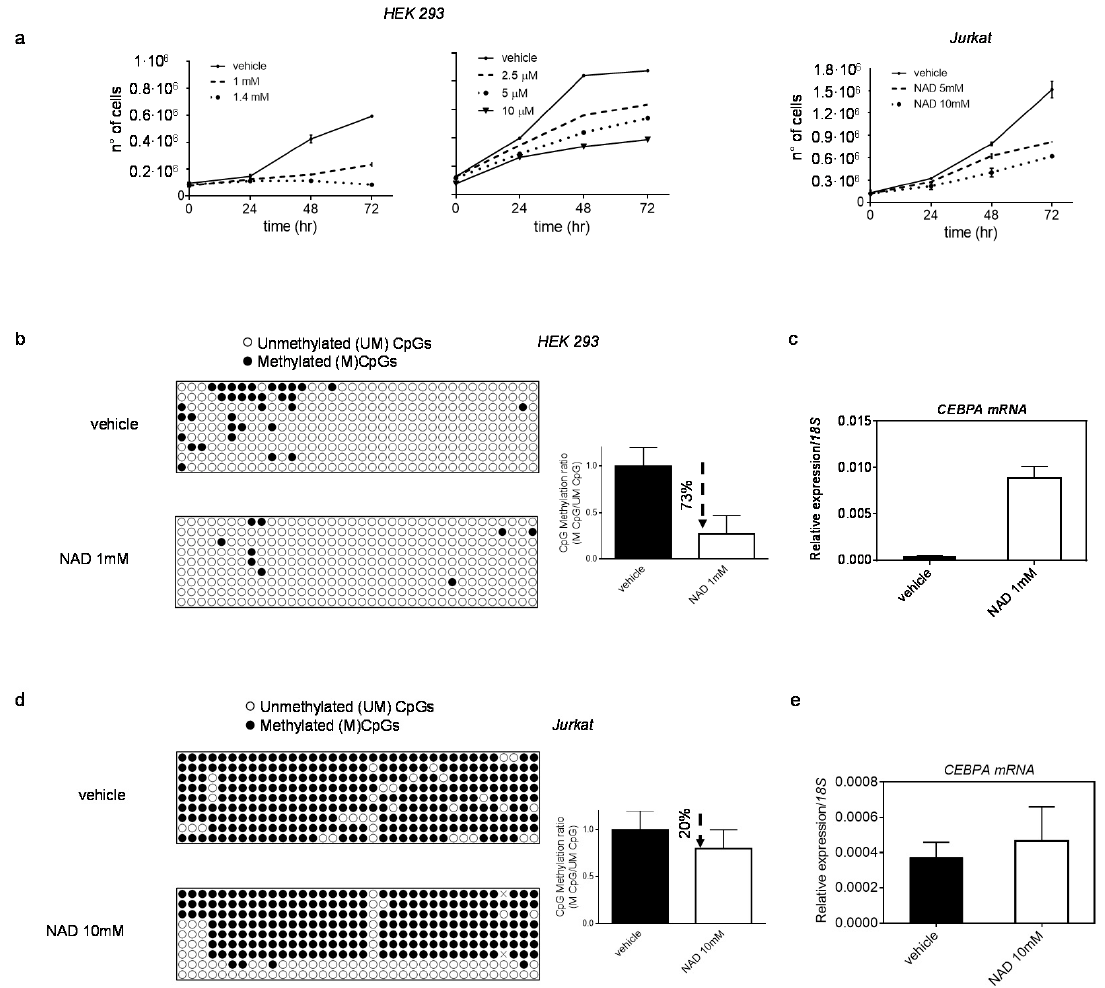
Figure 4. Effect of NAD treatment on CEBPA transcription in HEK 293 and Jurkat . Panel ( a ) HEK 293 and Jurkat growth curves in presence of NAD or vehicle. Cells were counted every 24 h for four days ( n = 3). ( b , c ) DNA methylation changes of CEBPA distal promoter (the − 0.8 kb region) in HEK 293 ( b ), and corresponding increase in CEBPA mRNA levels ( c ) 72 h upon treatment with NAD. ( d , e ) DNA methylation changes of CEBPA distal promoter (the − 0.8 kb region) in Jurkat ( d ), and corresponding increase in CEBPA mRNA levels ( e ), 72 h upon treatment with NAD. Lollipop graphs were generated using QUMA software. CpG methylation ratio, consisting of methylated CpGs divided by unmethylated CpGs, was calculated by QUMA software in all clones analysed per each construct ( n = 9). qRT–PCR, bars indicate mean ± s.d of three independent experiments ( n =